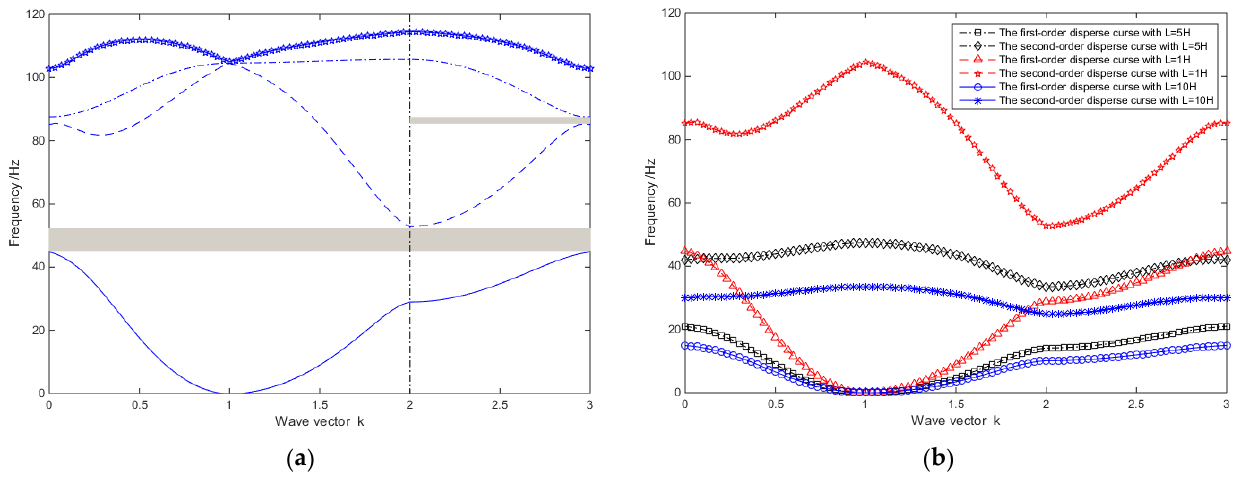
Figure 8. The dispersion curves under configuration B: ( a ) the first four disperse curves and ( b ) comparison of the first bandgap.